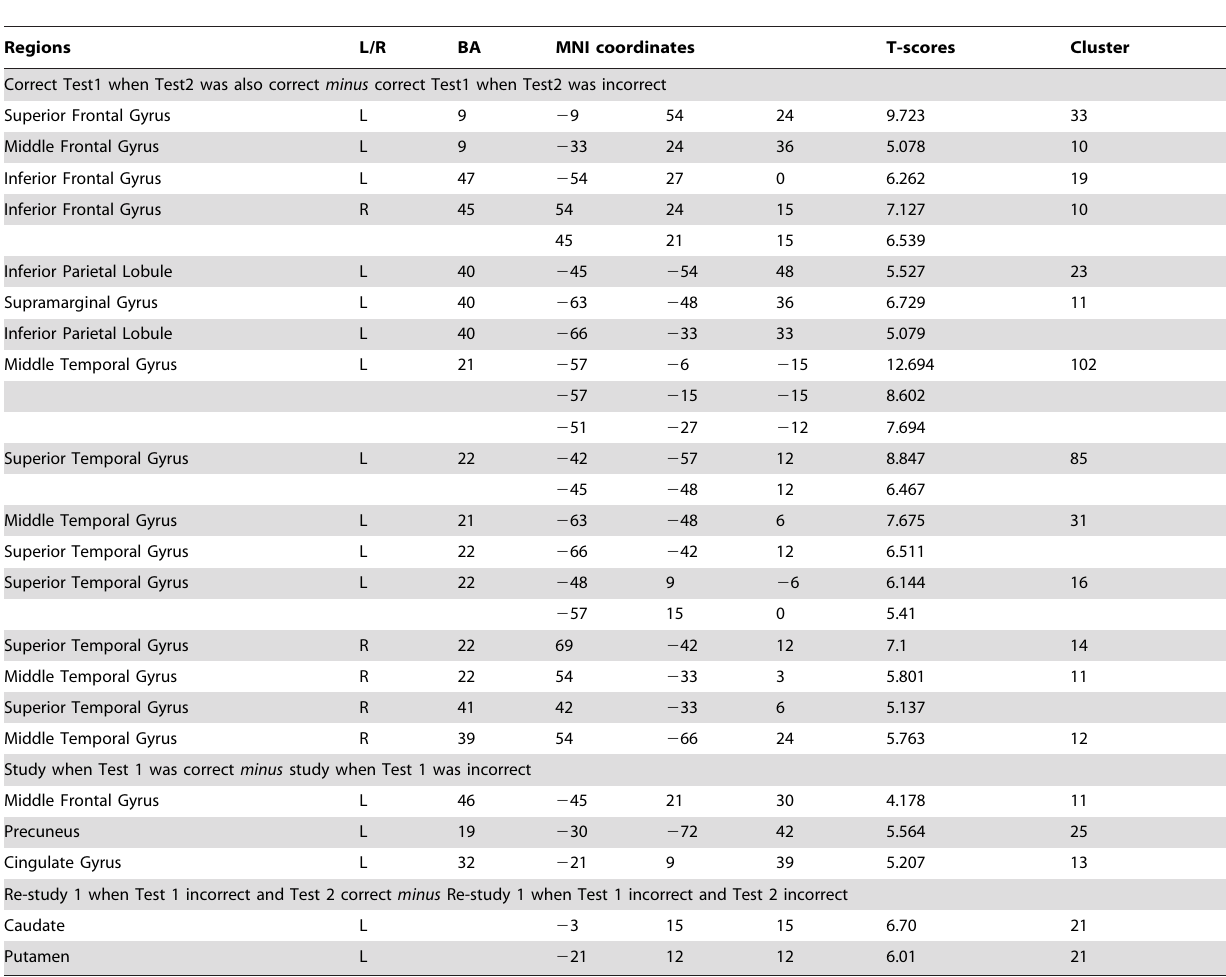
Table 1. Regions showing significant subsequent memory effects in each phase.